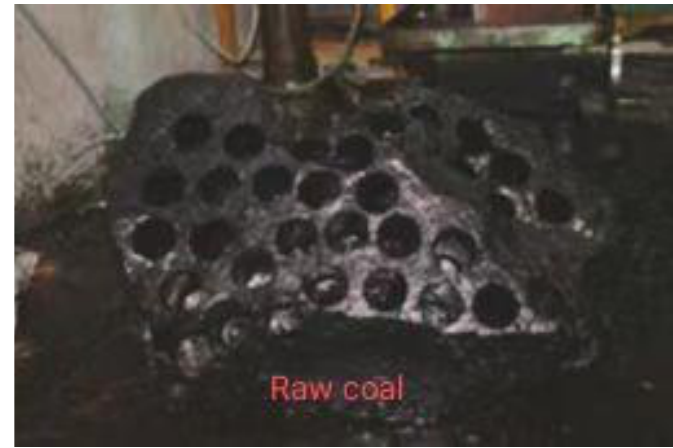
Figure 4. Drilling of raw coal test pieces.